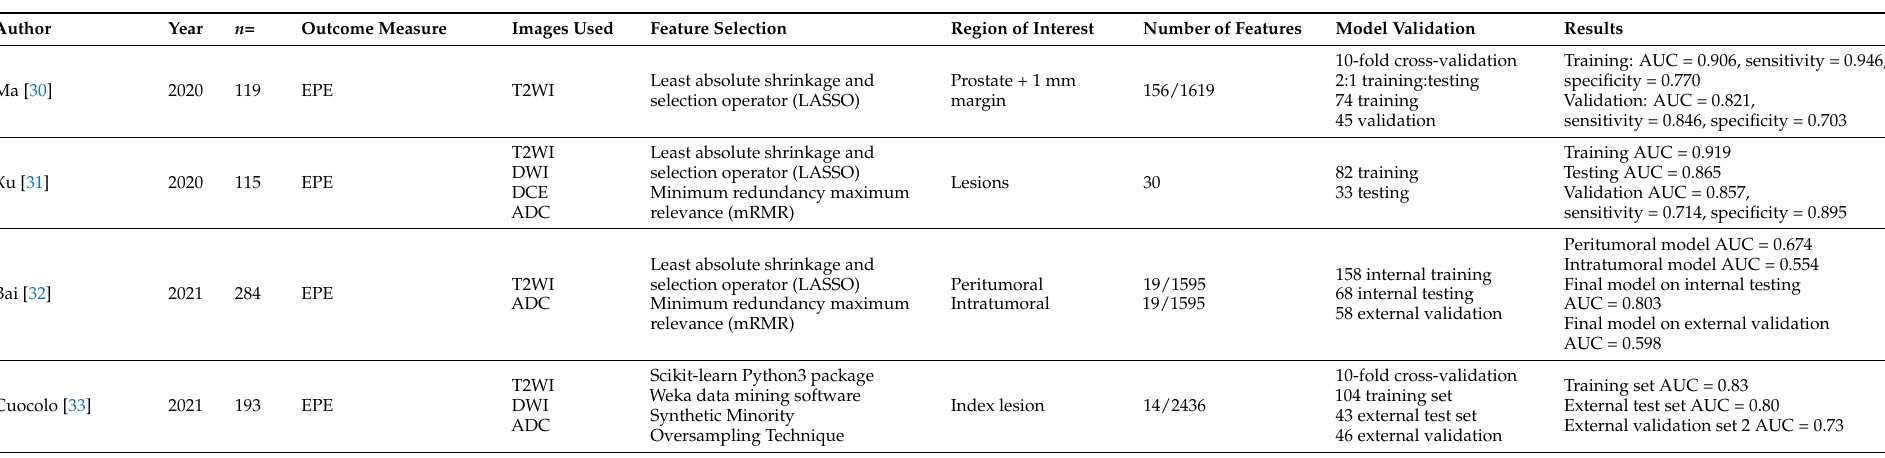
Table 2. Summary of studies utilizing MRI-derived radiomic models to predict adverse pathology (i.e., positive surgical margins, extraprostatic extension, and lymph node